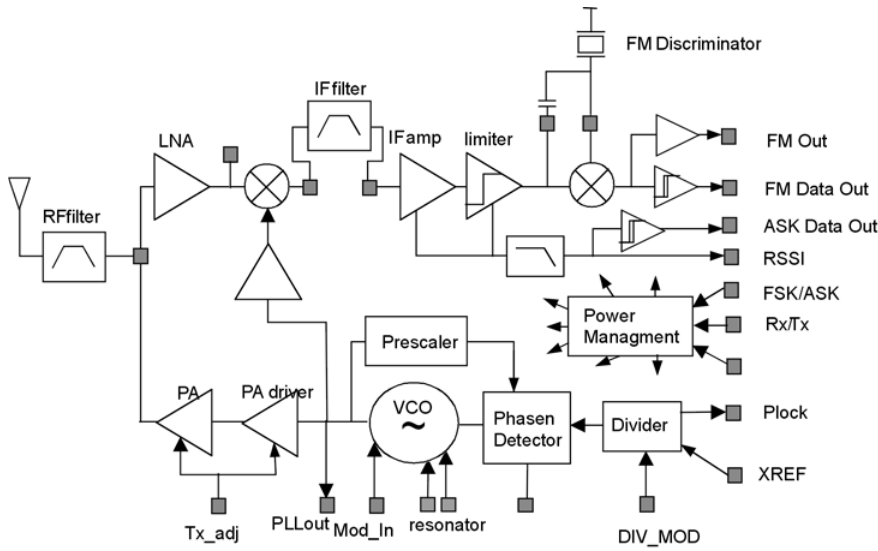
FIGURE 4 Block diagram for the realisation of the RF part